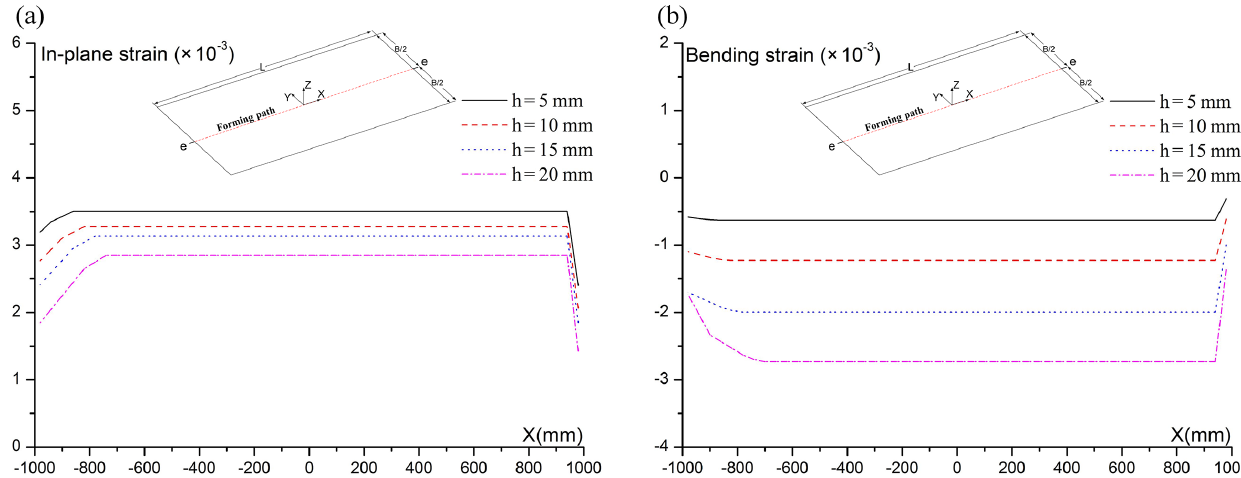
Figure 8. Relationship between plate thickness and midline strain variation of the rolling line of pressed plate. (a) In-plane strain distribution. (b) Bending strain distribution.